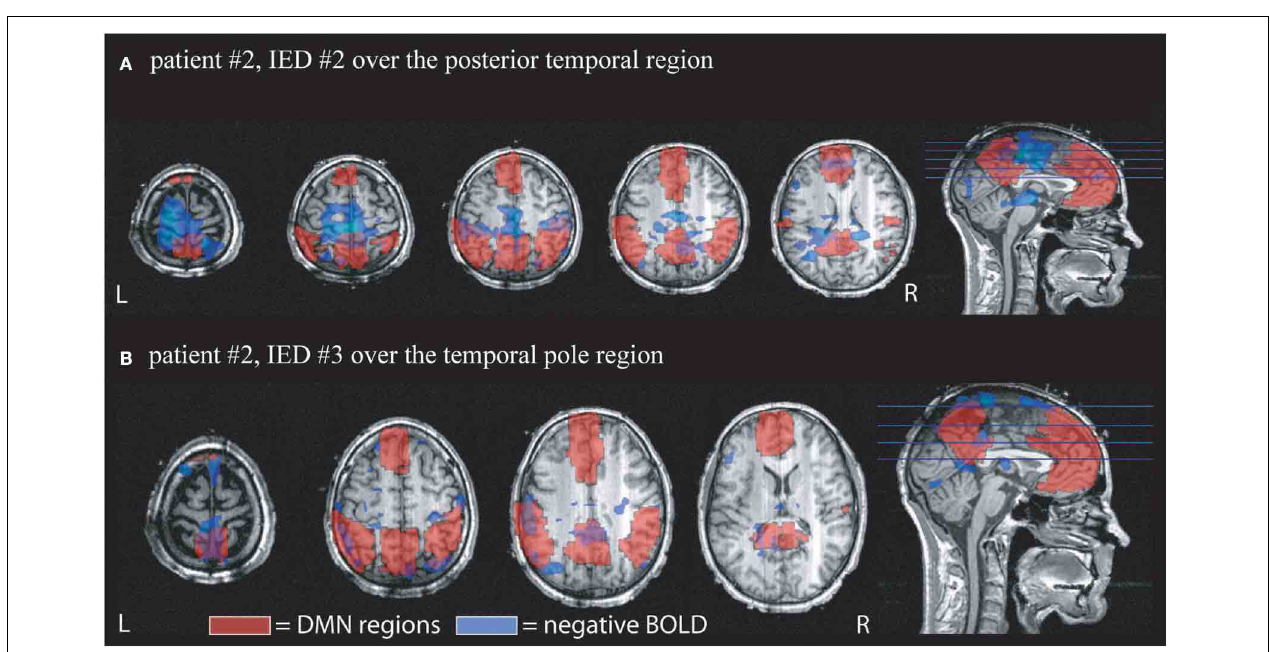
FIGURE 2 | Example of the overlap between negative BOLD responses and DMN regions. Patient # 2 had two different IED generated over the anterior and posterior region of temporal structures. DMN regions according to the AAL atlas are shown in red, negative BOLD in blue. (A) Shows the overlap for IED # 2 which occurred 4